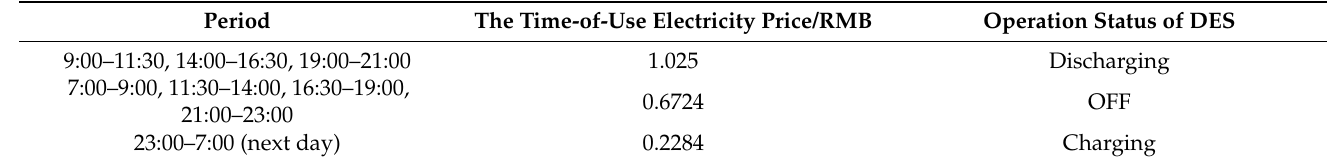
Table 4. The time-of-use electricity price and corresponding DES operation mode.